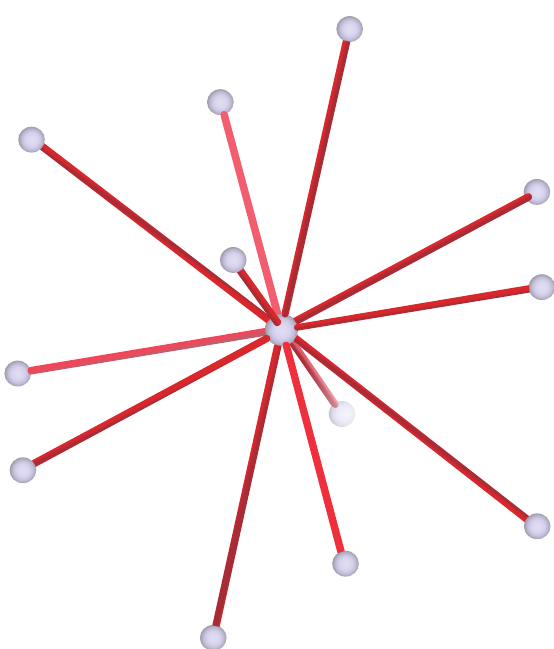
Figure 2: The vectors ±𝑌 1 ,...,±𝑌 6